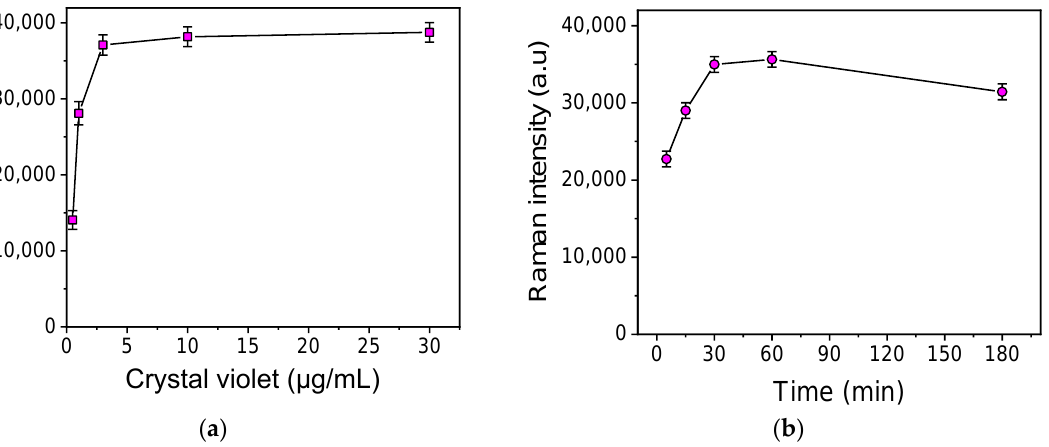
Figure 3. ( a ) Effect of CV concentration on Raman signal intensity at 915 cm −1 obtained from the SiNWs/Ag nanoparticles substrates. The substrates were incubated with the CV solutions for 3 h. ( b ) Effect of incubation time with the CV solution on the Raman signal intensity obtained from the SiNWs/Ag nanoparticle substrates. The CV solution concentration was 3 μg/mL. Each point is the mean value of measurements received from 3 substrates (3 different spots per substrate) ± SD.